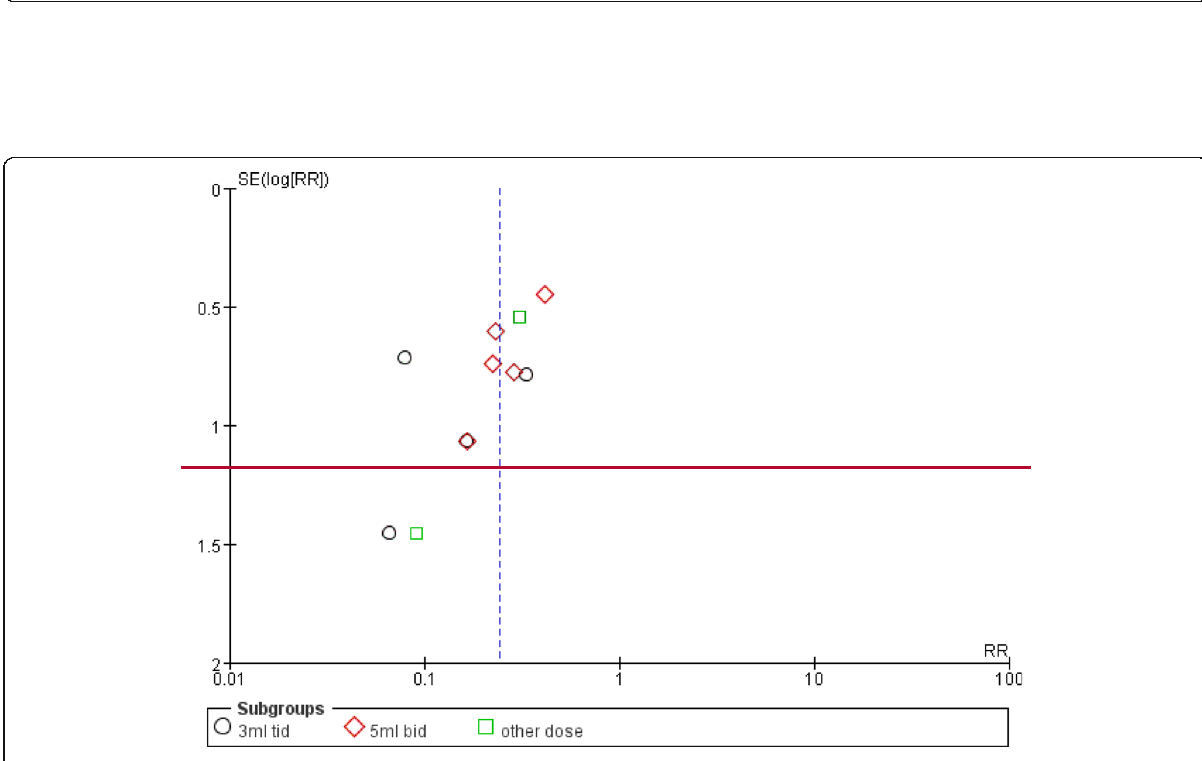
Fig. 6 Funnel plot of failure of jaundice resolution